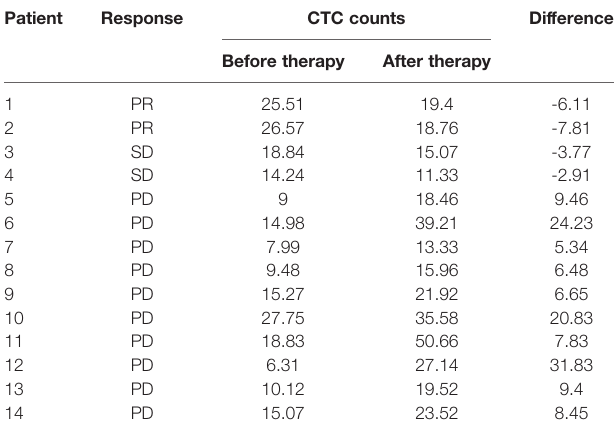
TABLE 3 | Changes of CTC counts correlated with response of chemotherapy in SCLC patients. Patient